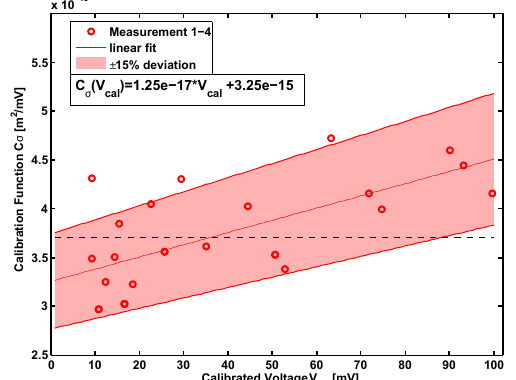
Figure 7. Actual ratio ( C σ ) between the calculated scattering cross section of PSL spheres and the calibrated voltage ( V cal ) measured by the light scattering detector plotted against V cal . A linear fit (red line) through the data points is used as scattering cross section cal- ibration function, C σ (V cal ), for the WELAS data analysis. Addi- tionally, the shaded area represents ± 15% deviation around the fit. Approximately 85% of all data points fall within this uncer- tainty. The black dashed line depicts the constant calibration factor C σ = 3 . 71 × 10 − 15 m 2 mV − 1 applied for Fig.